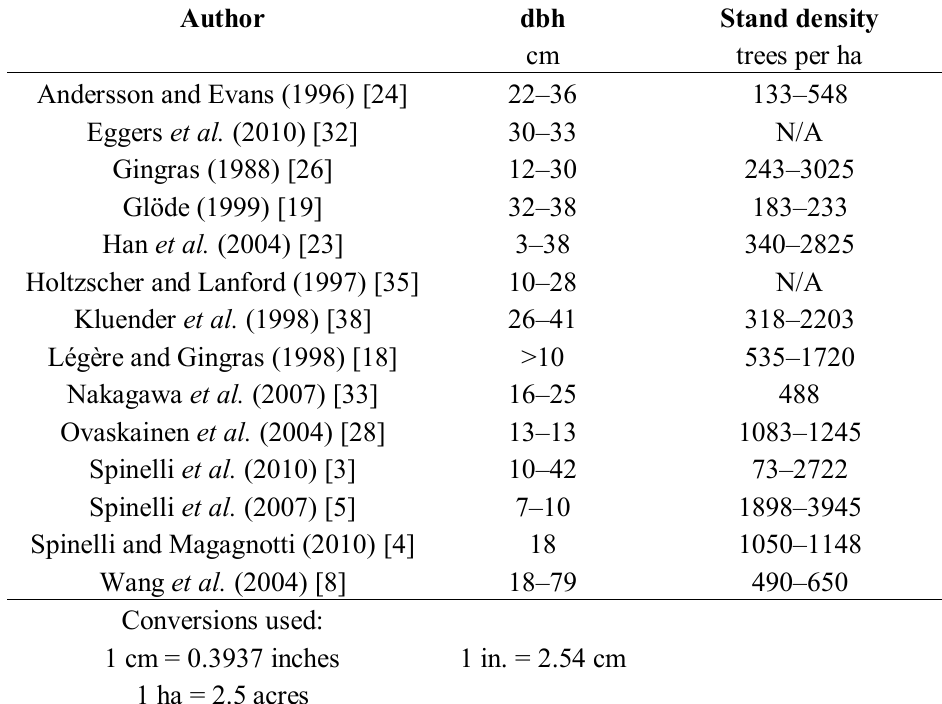
Table 4. Summary of dbh and stand density of timber harvesting